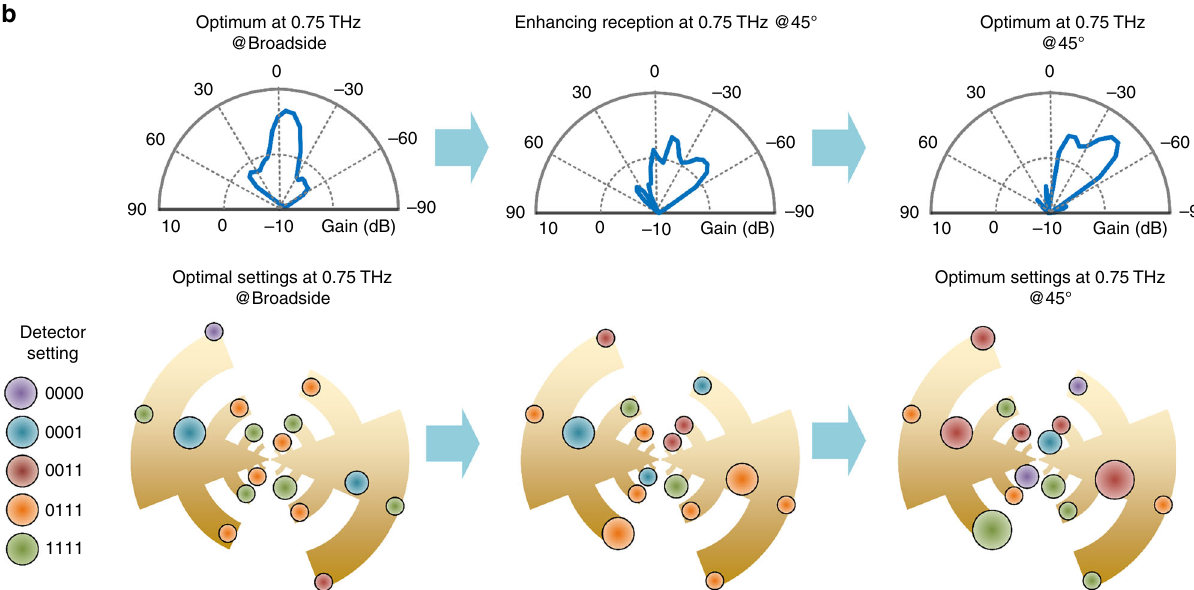
Fig. 4 Mapping the digital electromagnetic states to the incident THz sensor response. a Transformation of the beam patterns as the detector settings are reprogrammed across the 16-dimensional space from optimal reception from broadside at 0.3 – 0.75 THz. The beam patterns at both the frequencies can be seen to be transformed at the sensor is reprogrammed to shape its 0.75 THz pattern in the broadside. b Similar transformation of the reception beam at 0.75 THz as the surface is recon fi gured from optimal reception at broadside to 45° incidence at 0.75